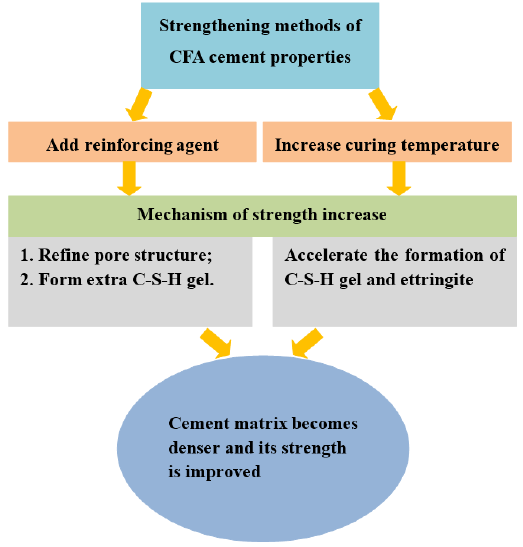
Figure 3. Modification methods and related mechanisms of CFA cement.